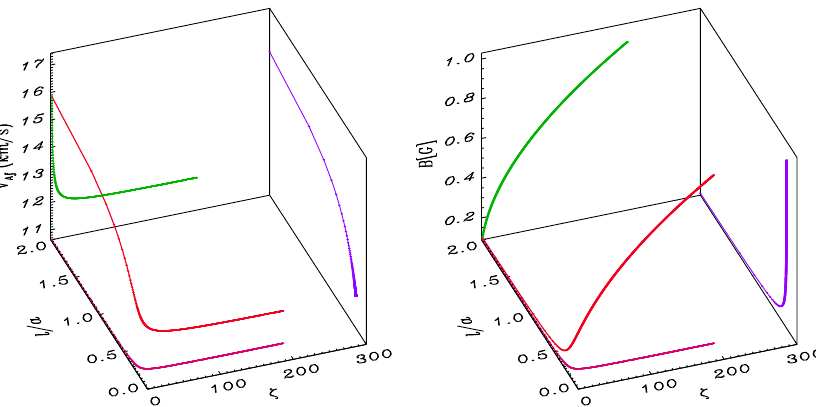
Fig. 85 Left: analytic inversion of physical parameters in the ( ζ , l / a , v Ap ) space for a filament thread oscillation with P = 3 min, τ d = 9 min and a wavelength λ = 3000 km (see, e.g., Lin et al. 2007). Right: magnetic field strength as a function of the density contrast and transverse inhomogeneity length-scale, derived from the analytic inversion for a coronal density ρ c = 2 . 5 × 10 − 13 kg m −